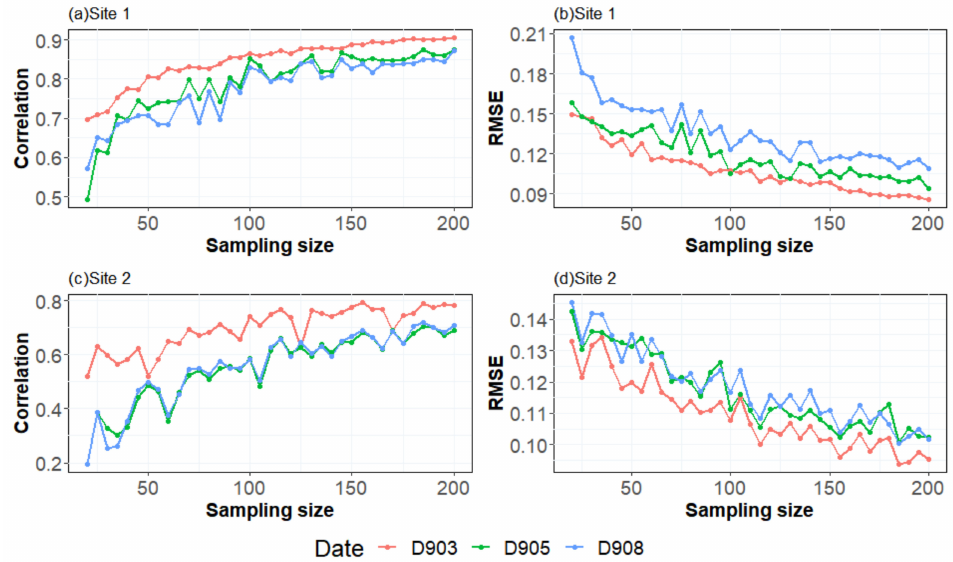
Figure 8. The correlation and RMSE between NDVI images on 3, 5, and 8 September and the predicted surface using the sampling points chosen, based on prior knowledge for 3 September: ( a , c ) correlation and ( b , d ) RMSE for the two